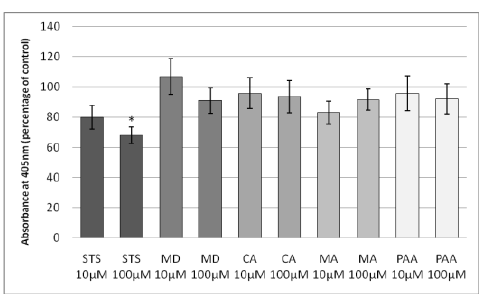
FIGURE 2I: ALP activity at 48 hours. Mean ± SEM, n = 12 * significant difference compared to the control